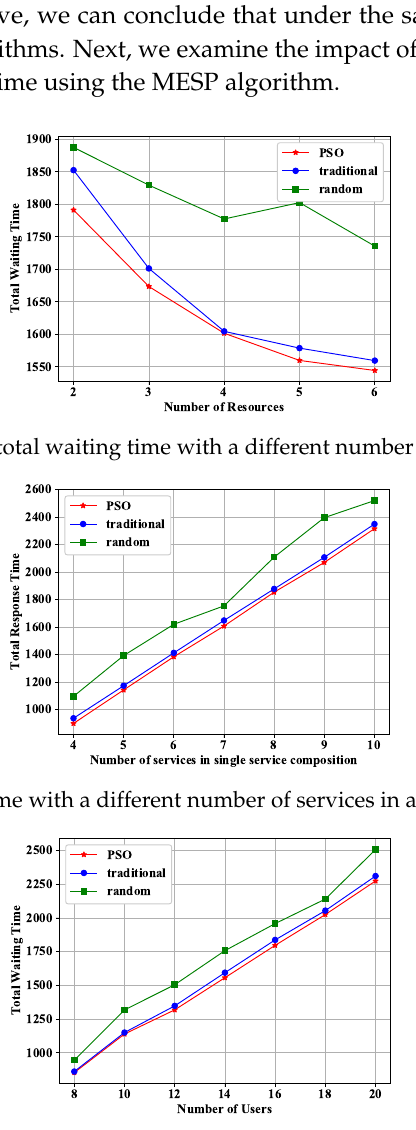
Figure 6. The total waiting time with a different number of